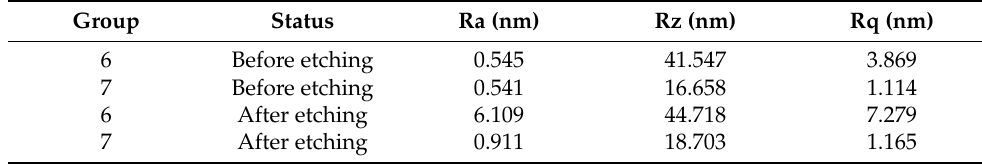
Table 3. Surface roughness comparison of each group after etching.